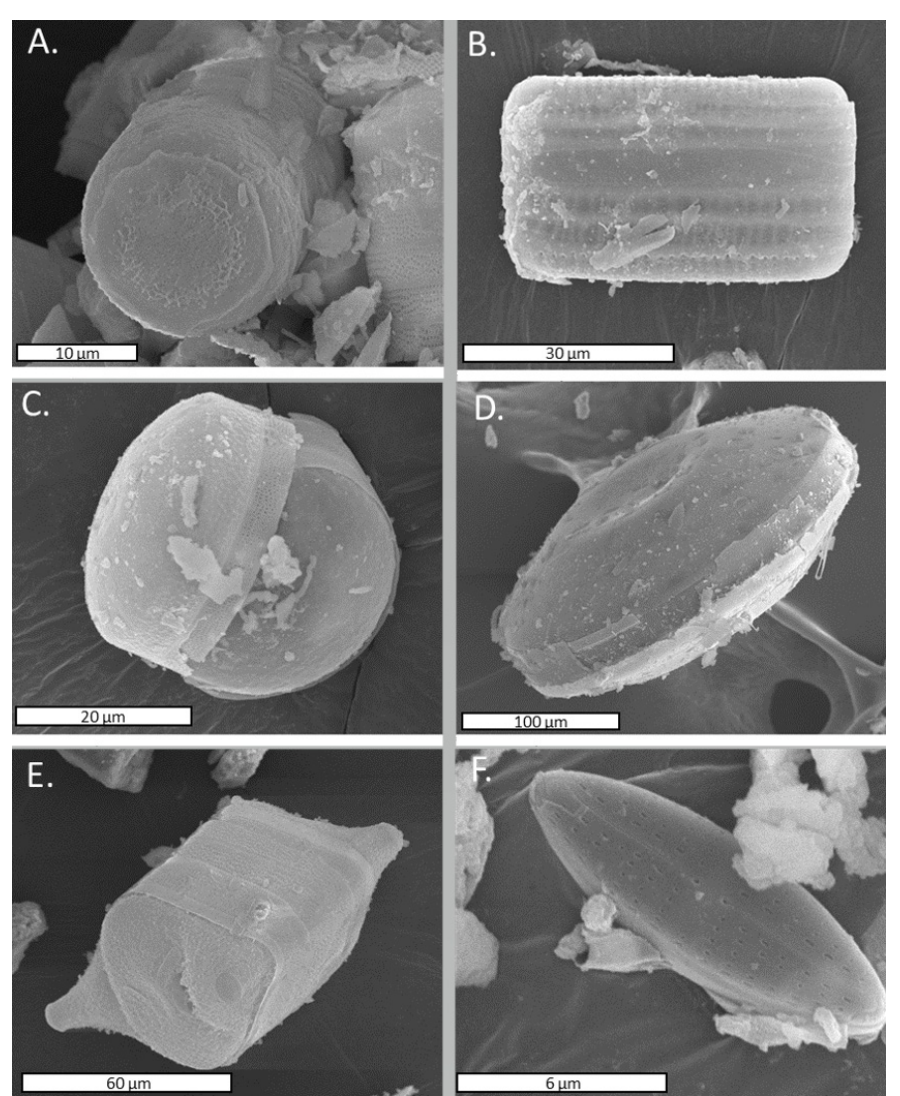
Figure 2 . Identified diatoms present in the sediment according to the morphological characteristics observed by SEM. ( A ) Dactyliosolen spp., ( B ) Thalassiosira spp., ( C ) Coscinodiscus spp., ( D ) Actynocyclus spp., ( E ) Odontella spp., ( F ) Psammothidium spp.